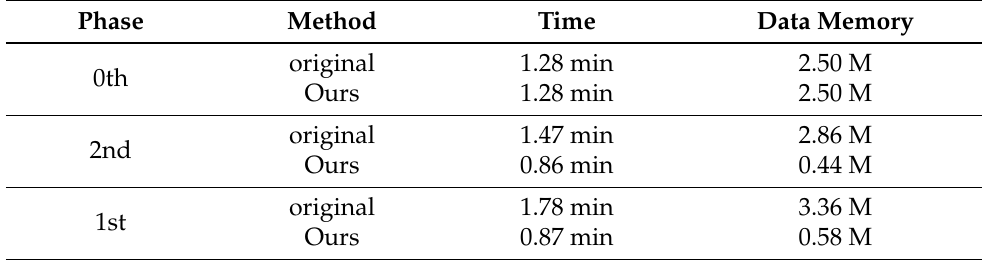
Table 6. Classification results of different